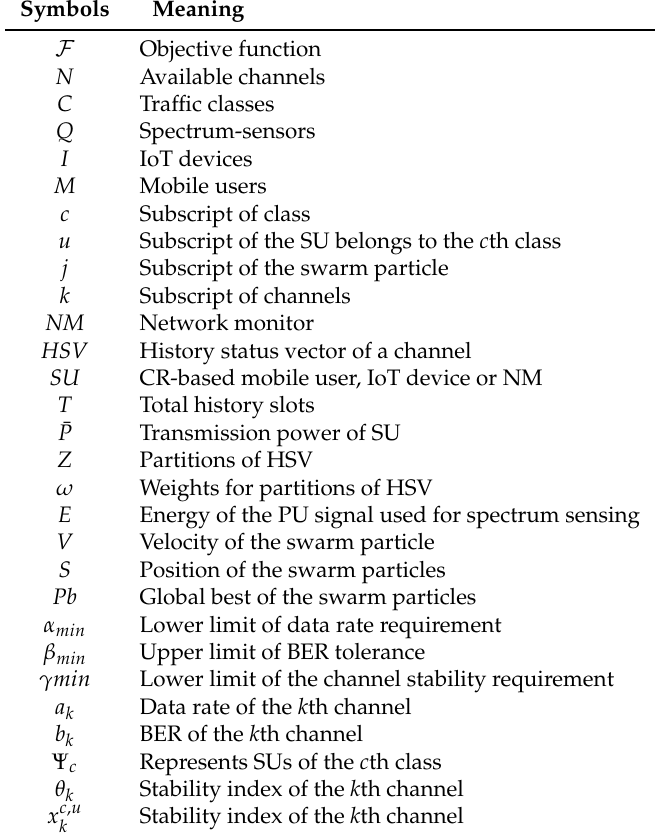
Table 1. Symbols and